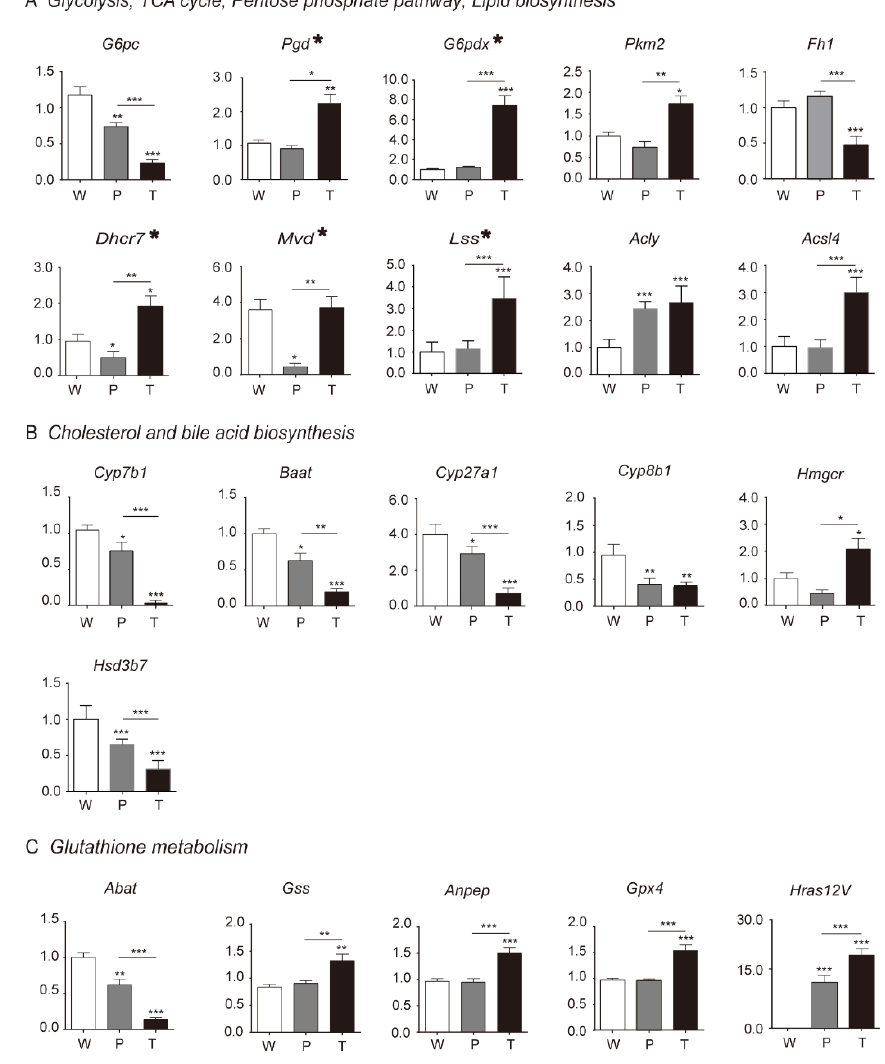
Figure 4. Validation of DEGs (differential expression of genes) in HCC, precancerous liver tissues, and normal liver tissues. The key DEGs involved in Figure 2 were validated using RT-qPCR assay at mRNA levels. ( A ) Glycolysis, TCA cycle, pentose phosphate pathway, and lipid biosynthesis correlated key DEGs were validated. ( B ) Cholesterol and bile acid biosynthesis correlated key DEGs were validated. ( C ) Glutathione metabolism correlated key DEGs were validated. The asterisk-marked genes in ( A ) indicate that they are also included in the pathways of ( B ) and ( C ). Abbreviations are the same, as mentioned in Figure